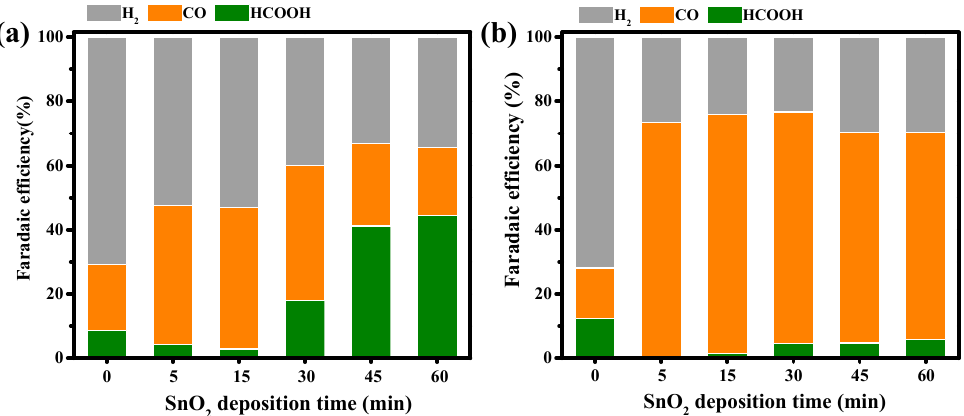
Figure 7. Comparison of FE s of H 2 , CO and HCOOH for ( a ) Cu / SnO 2 and ( b ) A-Cu / SnO 2 electrodes with different SnO 2 deposition time at − 1.0 V vs. RHE in CO 2 -saturated 0.1 M KHCO 3 .